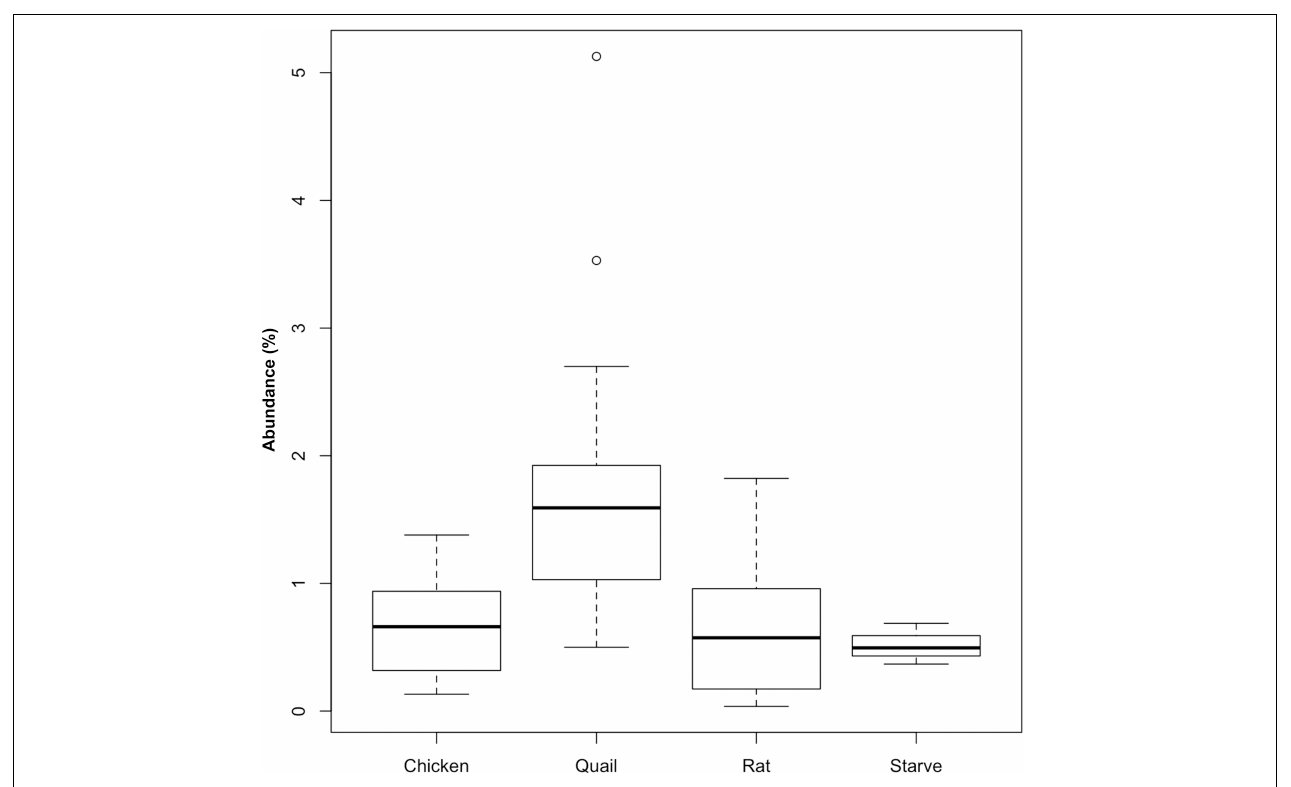
FIGURE 4 | Relative abundance of Actinobacteria in the fecal bacterial community of vultures varied according to prey type. Boxplots showing the relative abundance of Actinobacteria in fecal samples from Griffon vultures (seven individuals, n = 30 samples) fed either rat ( n = 12 samples) or quail ( n = 18 samples), and Egyptian vultures (six individuals, n = 22 samples) fed either quail ( n = 2 samples), rat ( n = 5 samples), or chicken ( n = 12 samples), or following a ‘fasted’ day ( n = 3 samples). For quail and rat prey types, fecal Actinobacteria abundance data from both vulture species were combined, but differences between prey type were only statistically significant for Griffon vultures ( P = 0.02). No statistical differences were detected between the four prey types fed to Egyptian